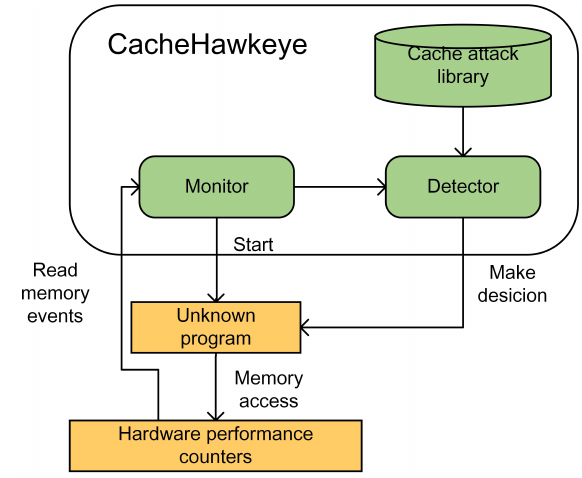
Figure 2. CacheHawkeye